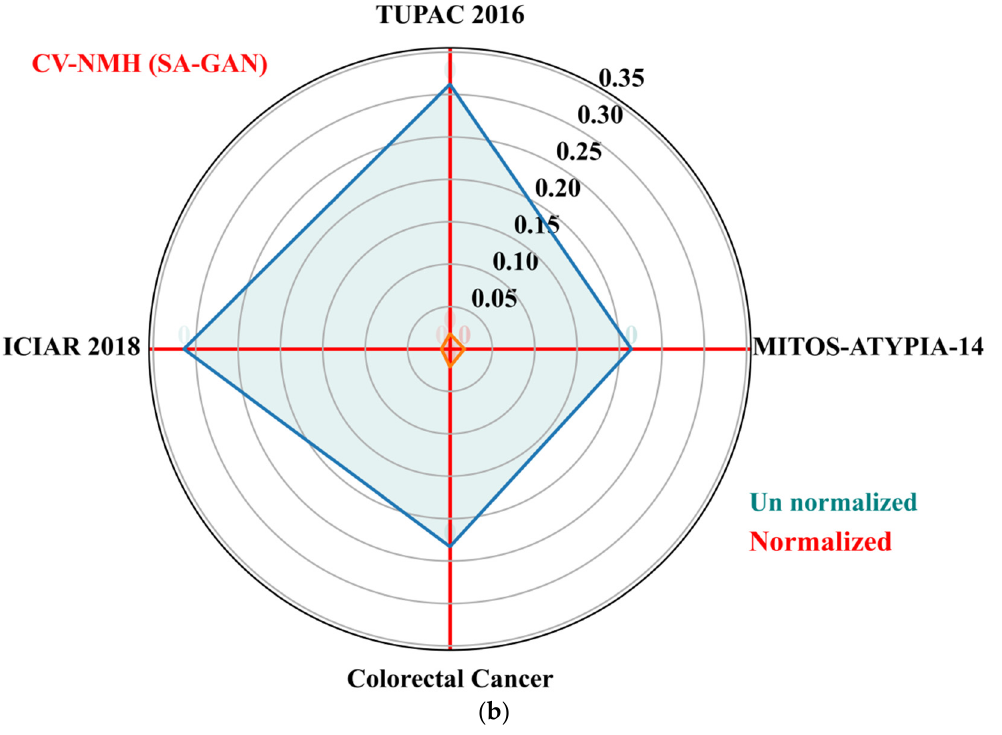
Figure 5. Polar plots of the CV-NMI ( a ) and CV-NMH ( b ) for proposed SA-GAN amongst the normalized training datasets and un normalized training datasets. Table 3. Evaluation of stain accumulation in terms of CV-NMI and CV-NMH.